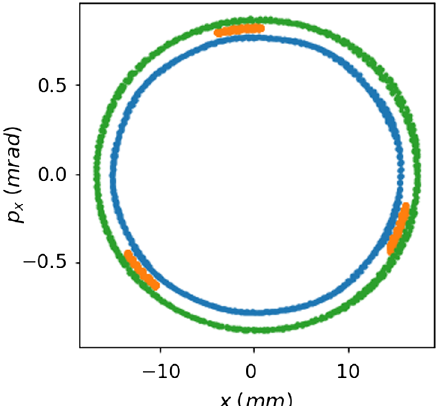
FIG. 11. Simulated turn-by-turn trajectories in phase space. A large tune-shift-with-amplitude coefficient shifts the tune away from the third order resonance quickly when the betatron amplitude is slightly off. The stop-band width for this lattice is FIG. 10. Frequency map of energy (momentum) acceptance in narrow, which means particle motion is stable even if its tune sits the x − δ planes. Here δ ¼ Δ p is the particles ’ relative momentum p on the deviation.